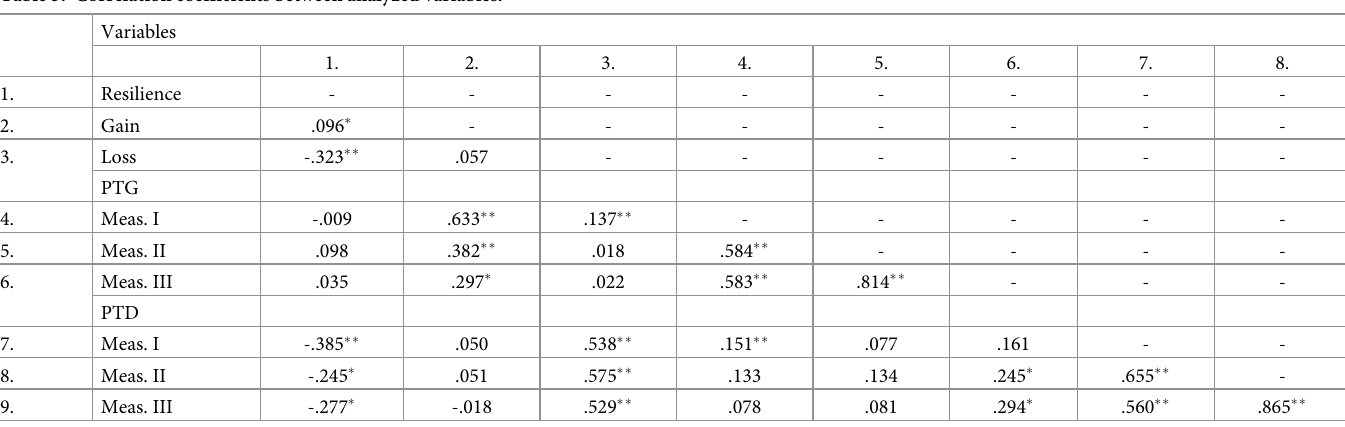
Table 3. Correlation coefficients between analyzed variables. Variables